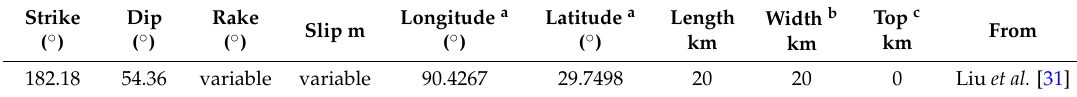
Table 2. Fault rupture parameters of the 6 October 2008 Dangxiong M W 6.3 earthquake.